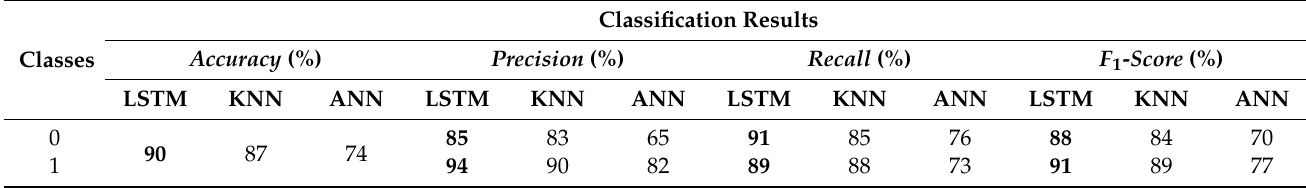
Table 6. Comparison of LSTM, KNN, and ANN model evaluation